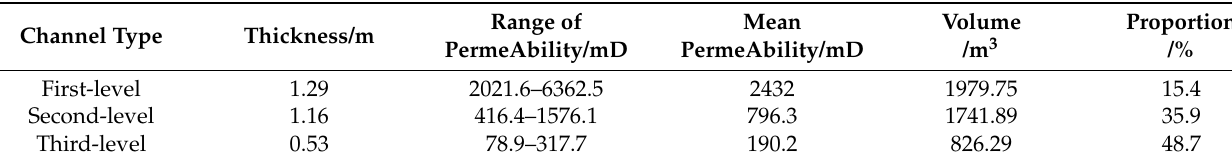
Table 1. Parameters of channels type.